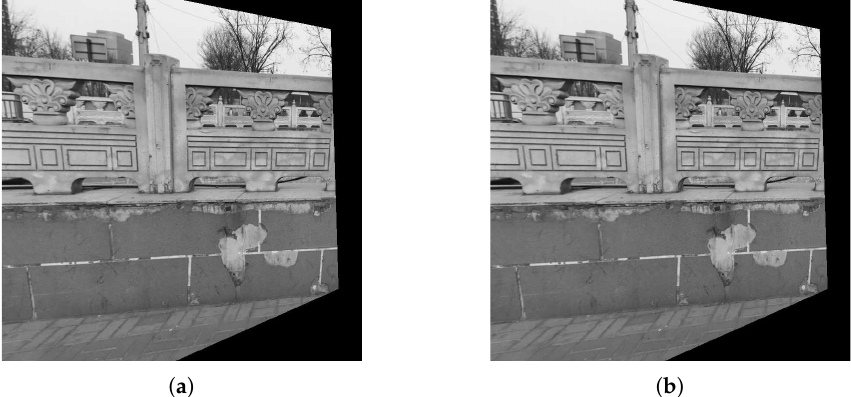
Figure 9. Registered results of the proposed methods for Fence image. ( a ) Dempster’s rule. ( b ) PCR6.